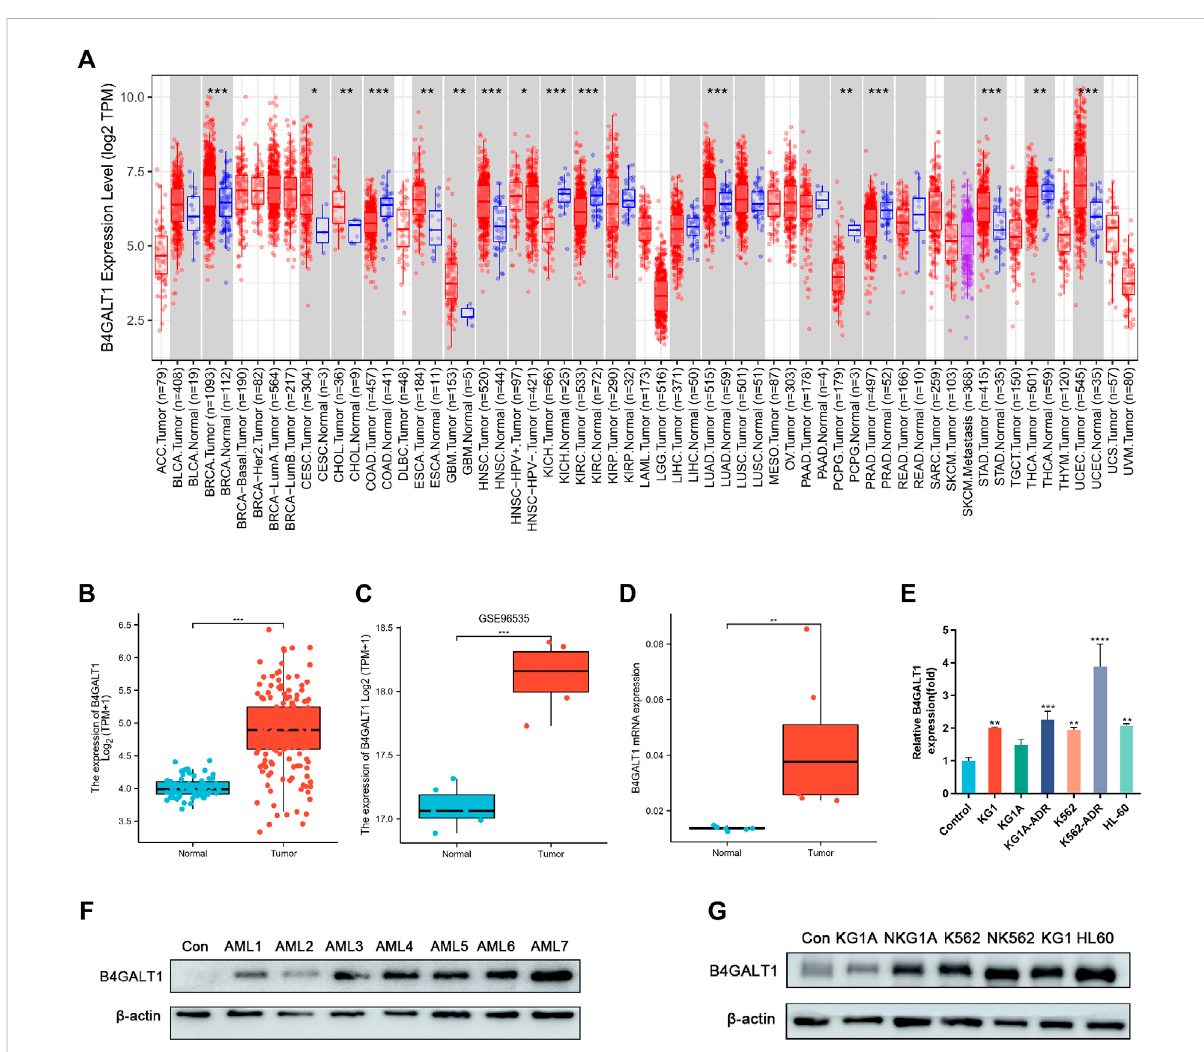
FIGURE 1 TheexpressionlevelsofB4GALT1indifferenthumancancers. (A) TIMERwasusedtodetecttheexpressionlevelsofB4GALT1indifferenttumors in The Cancer Genome Atlas (TCGA) database. (B) Expression level of B4GALT1 in paired normal and LAML samples. (C) Expression of B4GALT1 in tumor and normal samples from the GSE96535 dataset in the Gene Expression Omnibus (GEO) database. (D) Quantitative mRNA expression of B4GALT1byqRT-PCRinLAMLpatientsamples( n =8)andcontrols( n =6). (E) TranscriptionallevelofB4GALT1indifferentLAMLcelllines. (F – G) Western blot detecting the protein expression level of B4GALT1 in patients and different LAML cell lines. Analysis between two groups: